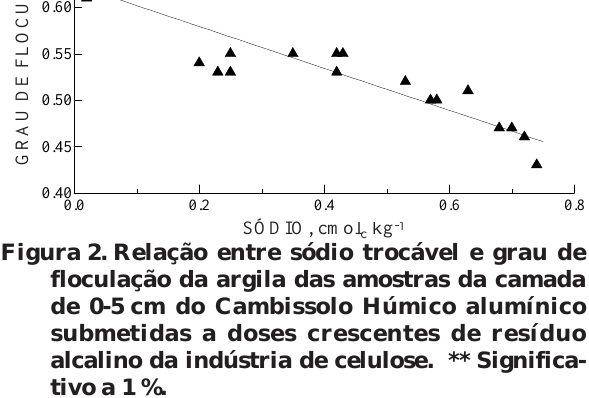
2. Relação entre sódio trocável e grau de floculação da argila das amostras da camada de 0-5 cm do Cambissolo Húmico alumínico submetidas a doses crescentes de resíduo alcalino da indústria de celulose. ** Significa- tivo a 1 %.